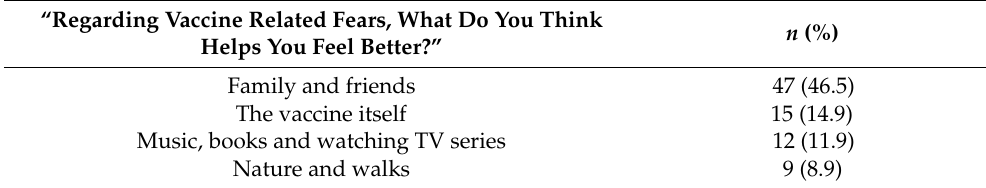
Table 3. Basal descriptive personal coping resources (N = 101) results in the total